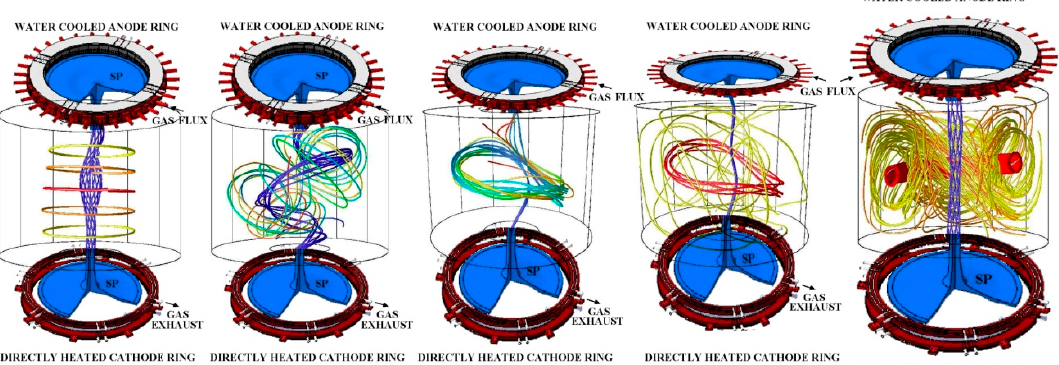
Figure 1. Formation and evolution of the PROTO ‐ SPHERA central column and spherical torus plasma (developed from the three ‐ dimensional simulations by García Martínez and Farengo [45,46]).